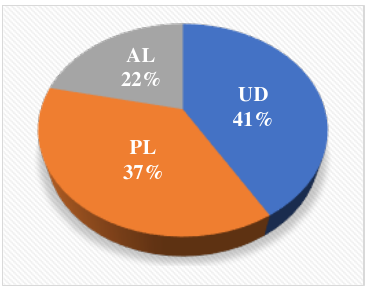
Figure 9. The label distribution among all